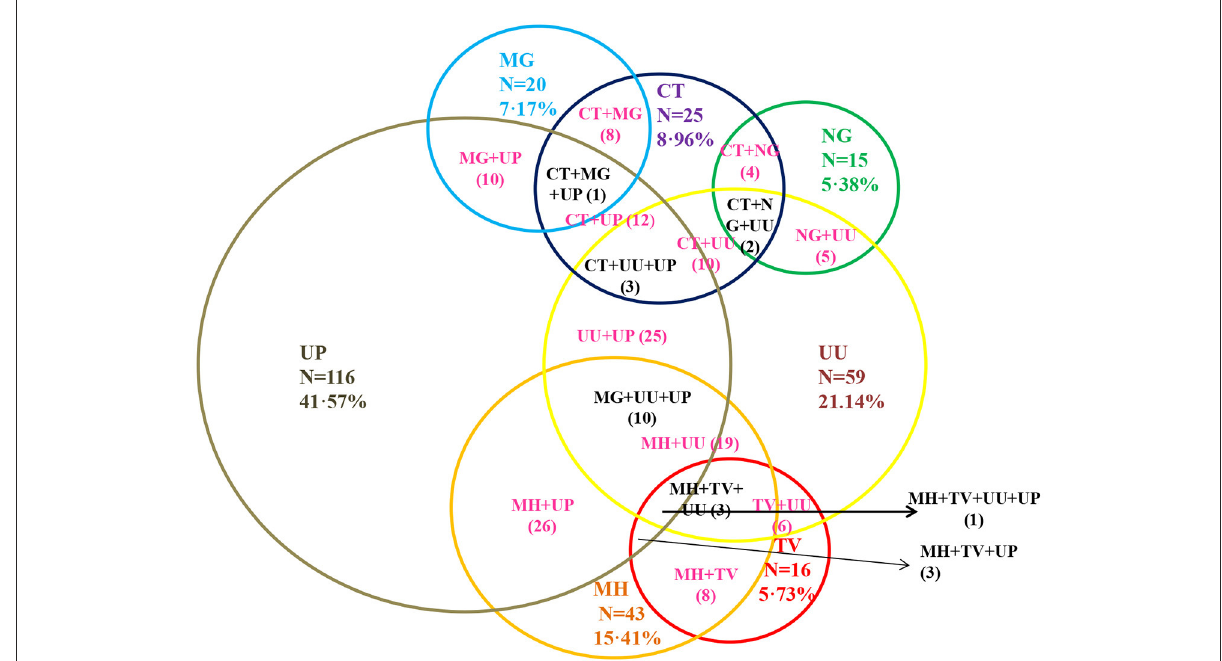
FIGURE3 Prevalence of sexually transmitted infection and genital mycoplasmas among the asymptomatic adolescent girls. CT, Chlamydia trachomatis; NG, Neisseria gonorrhoeae; MG, Mycoplasma genitalium; TV, Trichomonas vaginalis; MH, Mycoplasma hominis; UU, Ureaplasma urealyticum; UP, Ureaplasma parvum out of the total asymptomatic adolescent subjects enrolled in the study is shown. DNA was isolated from samples collected from asymptomatic adolescent women and infection for these seven pathogens was determined by Real time PCR based diagnosis. Among total positive prevalence for CT, NG, MG, MH,TV, UU, UP were 8.96, 5.38, 7.17, 15.41, 5.73, 20.79, and 41.22%, respectively.